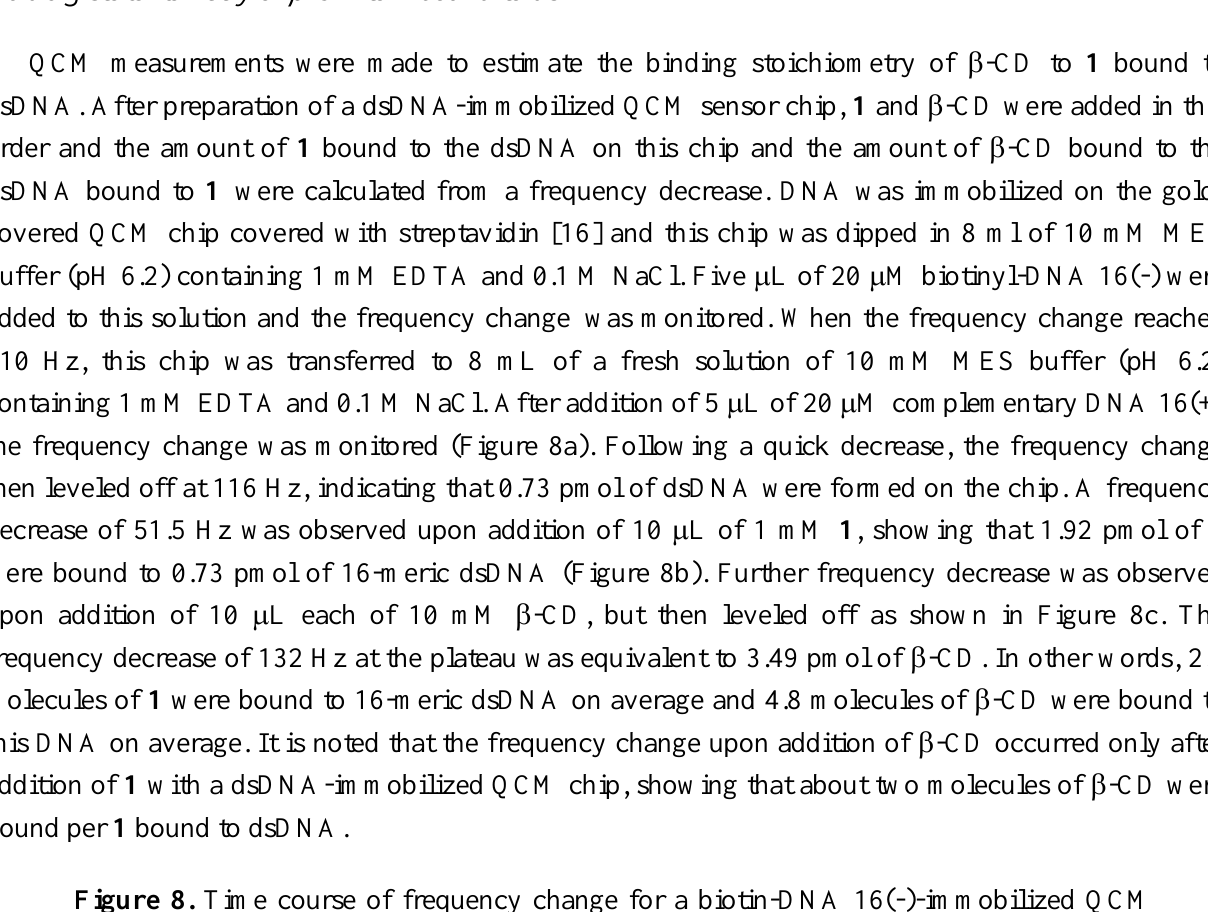
Figure 8. Time course of frequency change for a biotin-DNA 16(-)-immobilized